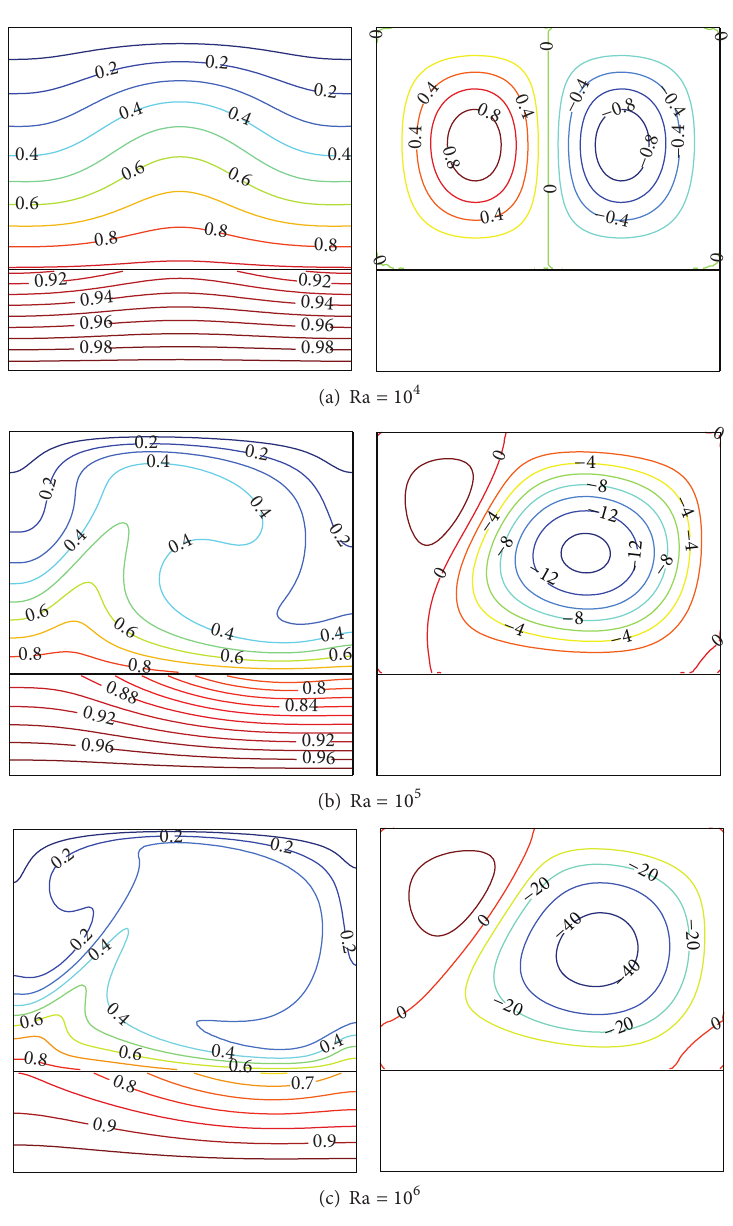
Figure 5: Isotherms (left) and streamlines (right) at 𝐷 = 0.3 and Kr = 5